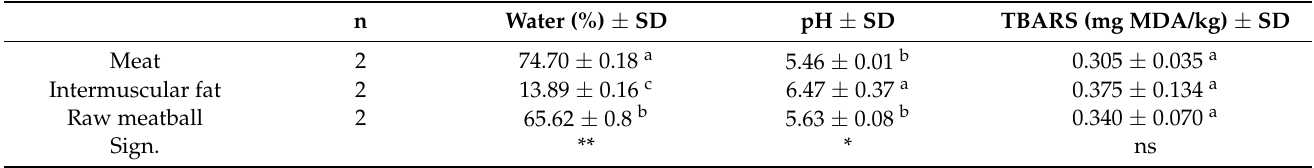
Table 1. Various analysis results of raw